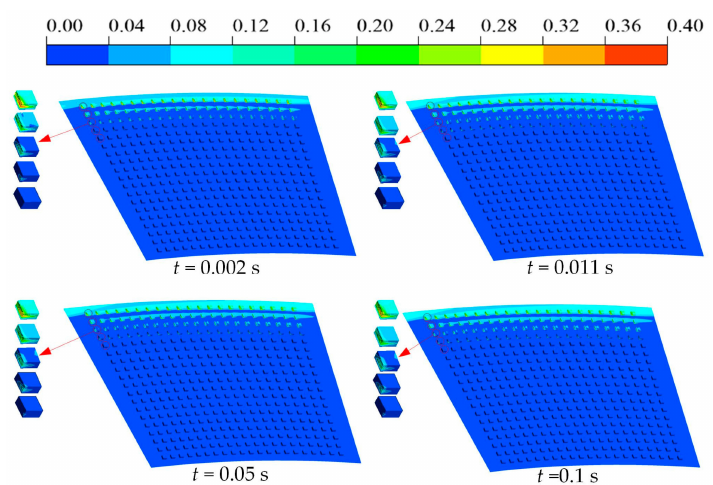
Figure 20. Cavitation morphology change with hexahedral texture rate